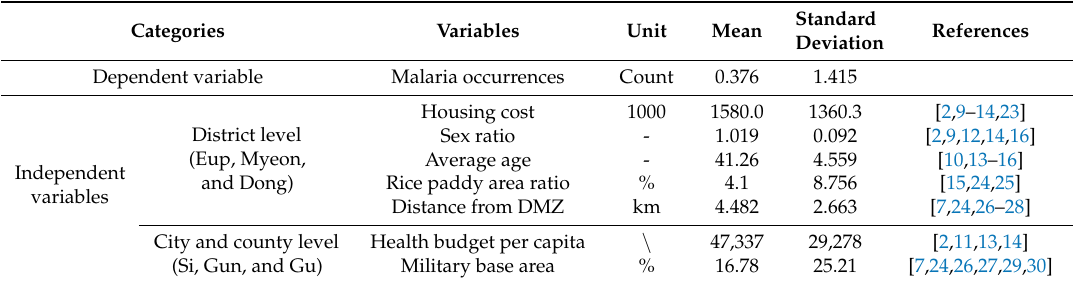
Figure 2. Study area of the research. Table 1. Descriptive statistics and references for the variables in the research. DMZ: demilitarized zone.